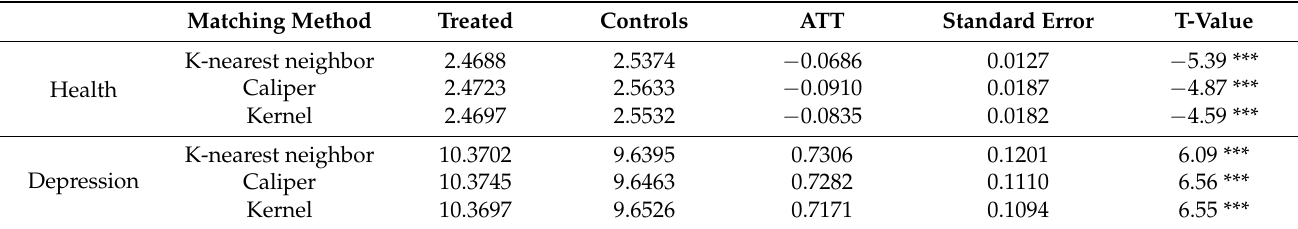
Table 6. Empirical results of propensity score matching.